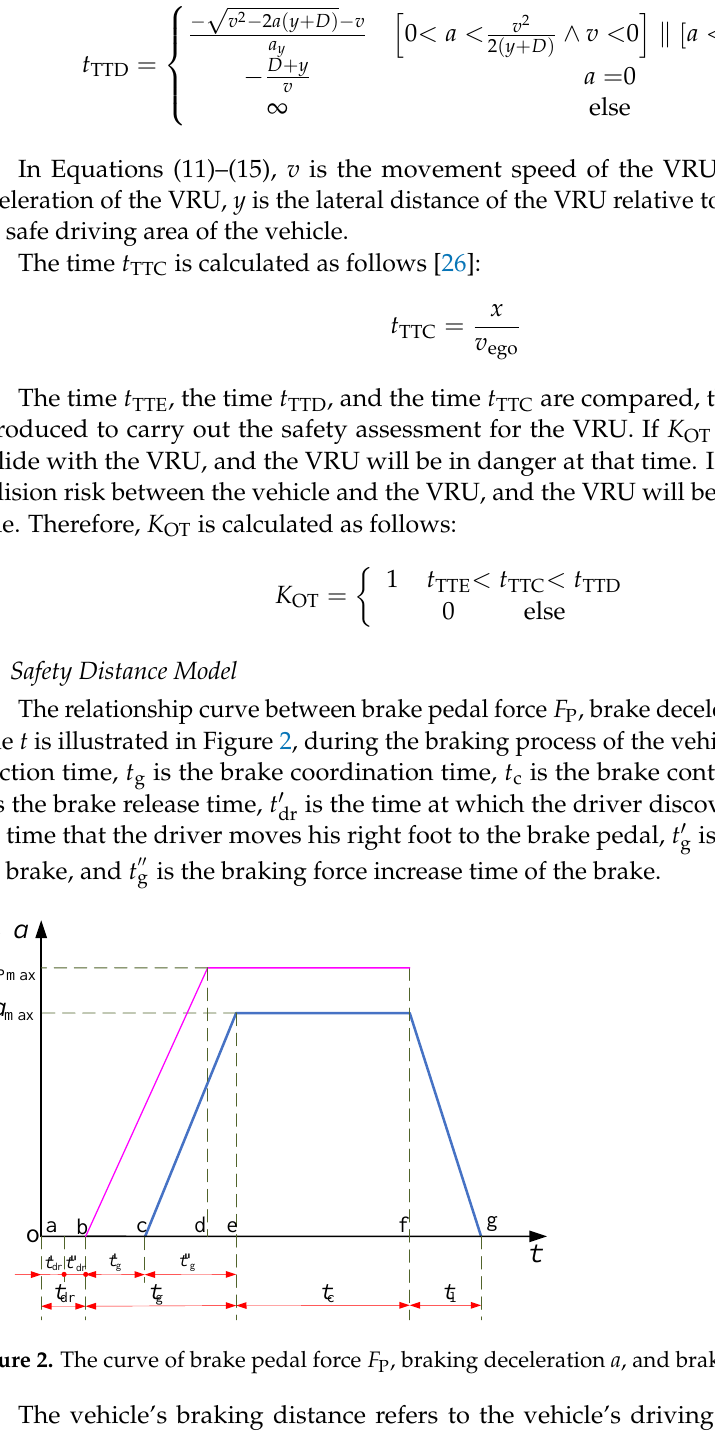
Figure 2. The curve of brake pedal force P